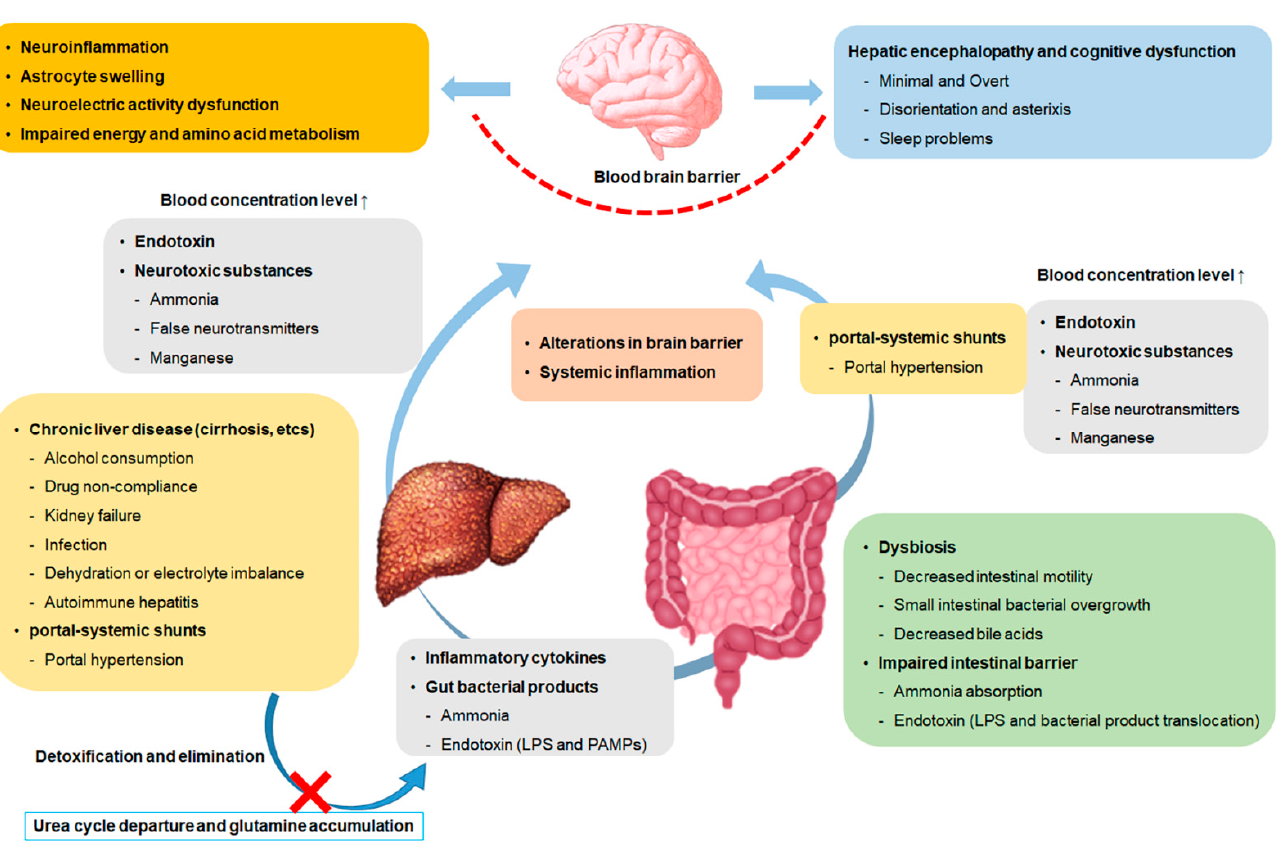
Figure 1. Schema of brain dysfunction by the gut-liver-brain axis. LPS, Lipopolysaccharide; and PAMPs, pathogen-associated molecular patterns.